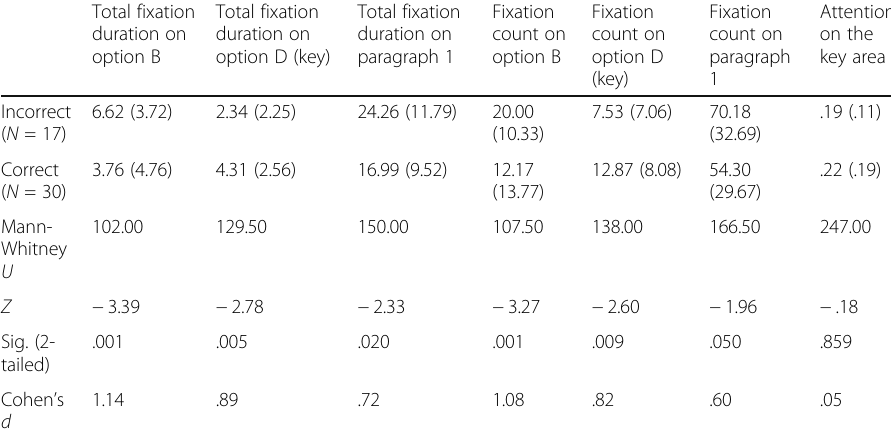
Table 11 Eye-tracking statistics for item